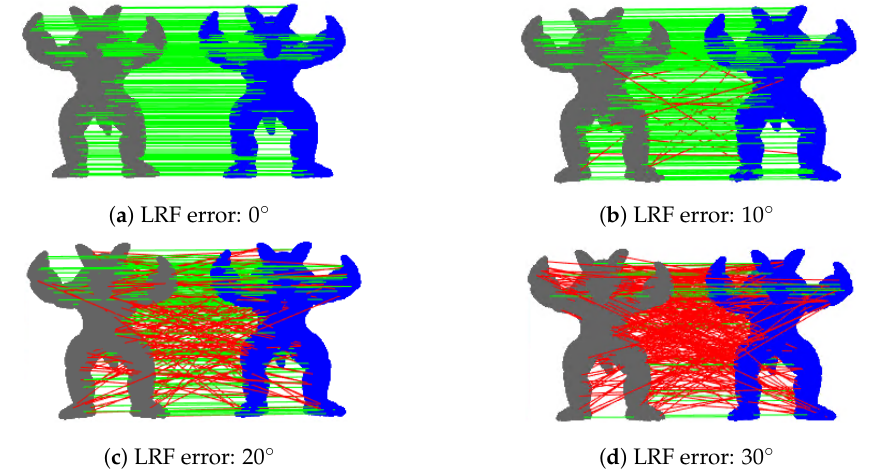
Figure 7. The influences of different LRF errors on descriptor (RoPS) matching. Gray represents the model, blue represents the scene, the green line represent correct matching, and the red line represent wrong